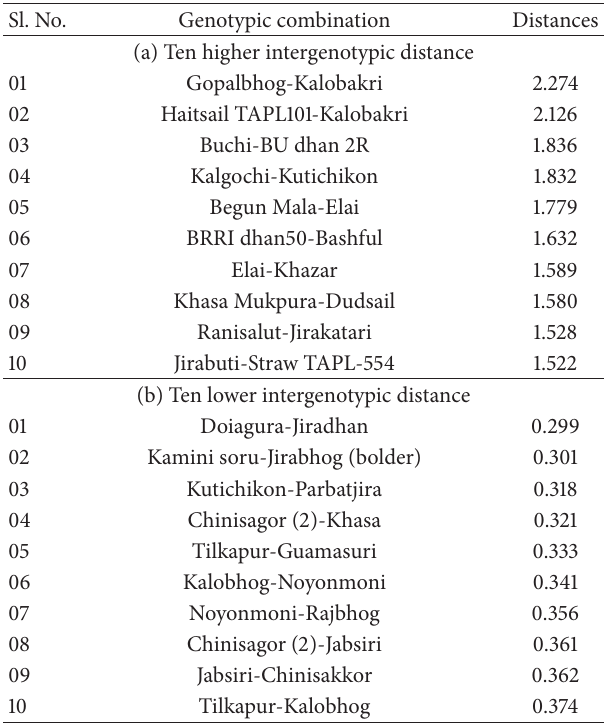
Table 9: Ten higher and ten lower intergenotypic distances among the 113 aromatic and fine rice genotypes. Sl.